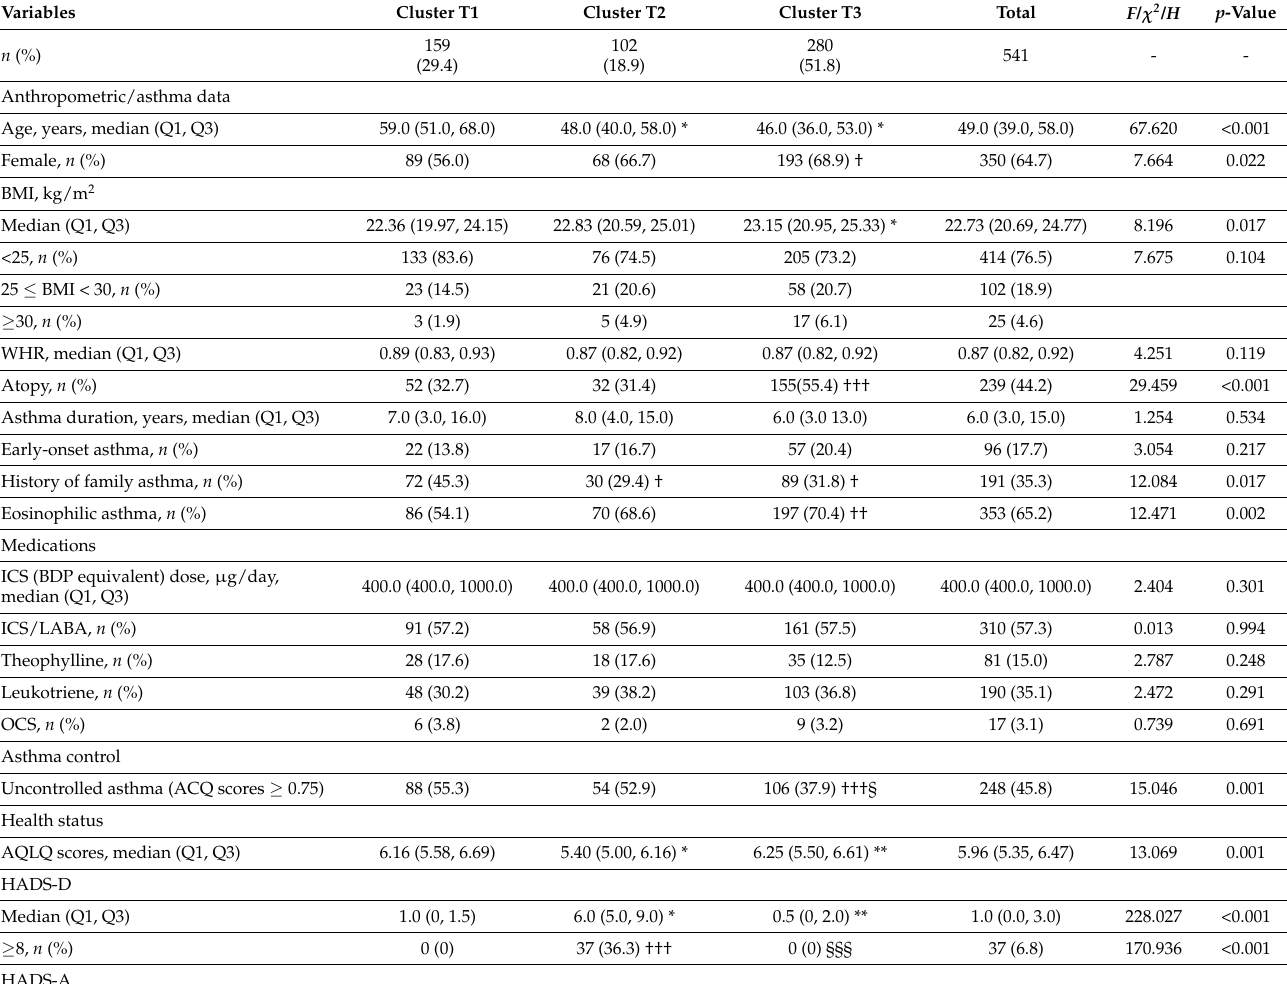
Table 1. Demographic and clinical characteristics of the included participants with asthma grouped by cluster analysis in the training